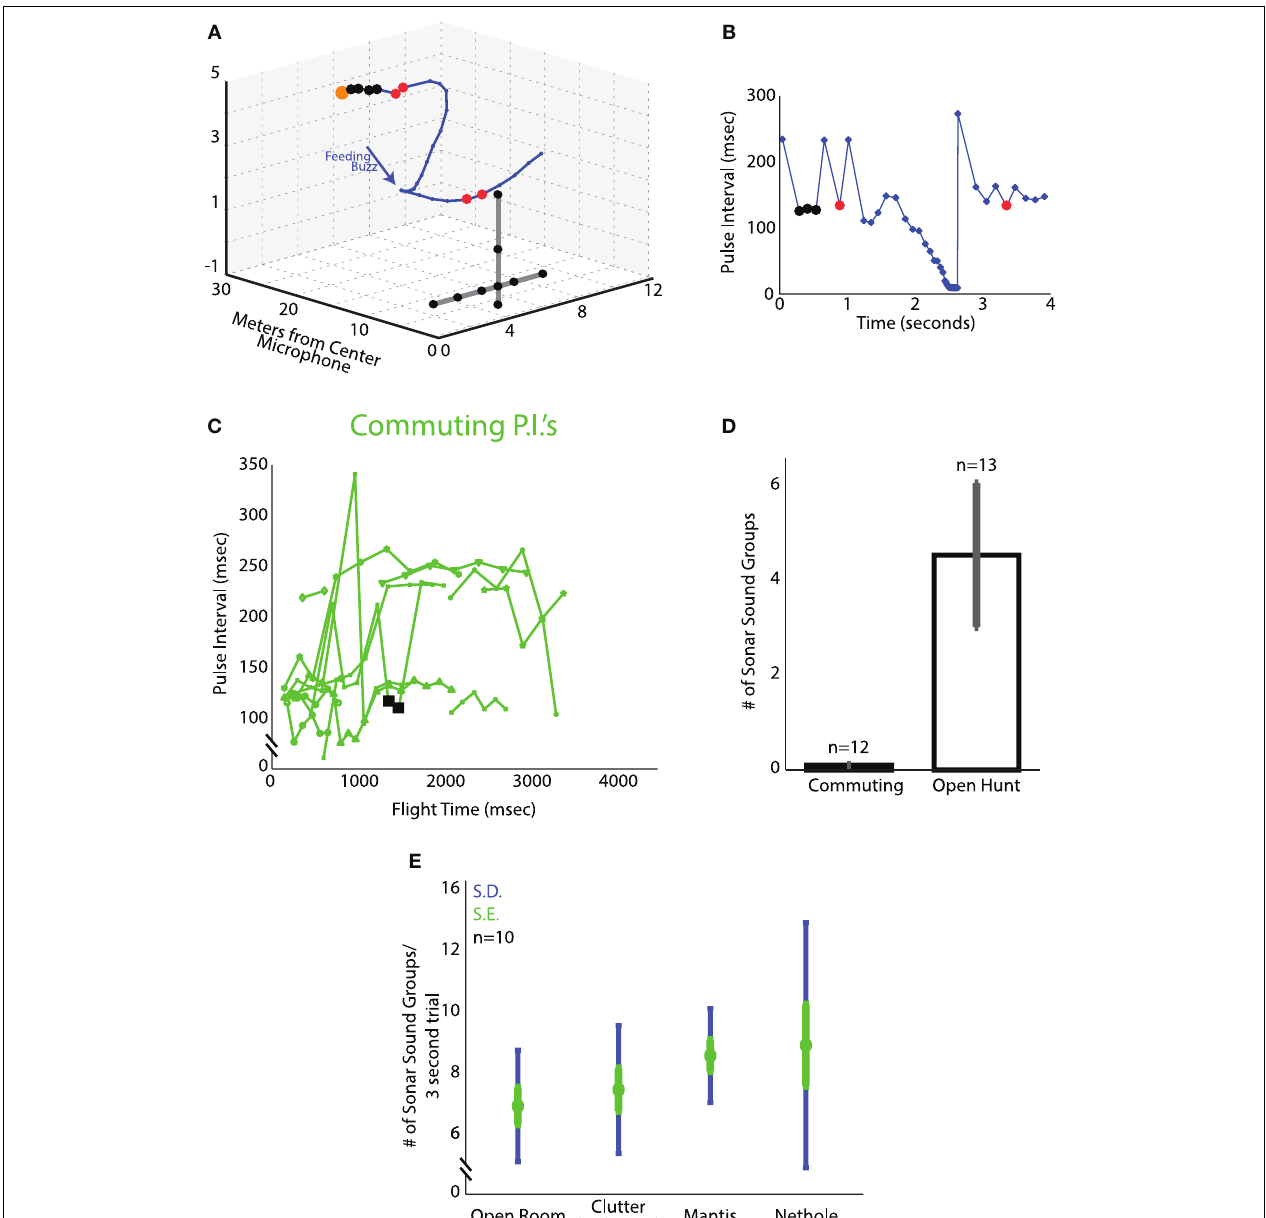
FIGURE 4 | Sonar sound groups under varying conditions. (A) One trial plotted in 3D from the Lake Artemesia field site. The bat’s flight path is shown in blue, and timing of the vocalizations with blue dots. Black dots highlight vocalizations in a 4 call sound group, calls marked in red are 2-call sound groups (sonar call doublets). The microphone array is shown in black. (B) Time vs. pulse interval for the trial shown in (A) . As in (A) , P.I.’s marked with black are 4 call sound groups, and those with red dots are sonar call doublets. (C) Time vs. pulse interval for the recordings of commuting bats at Rockville, MD. Only one sequence of vocalizations